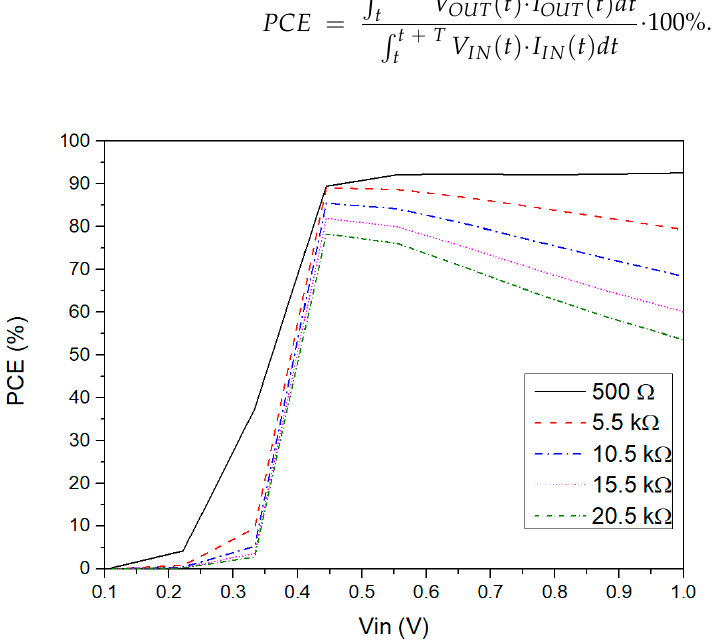
Figure 7. PCE versus input voltage amplitude simulated for different values of R (cid:2896)(cid:2899)(cid:2885)(cid:2888) .